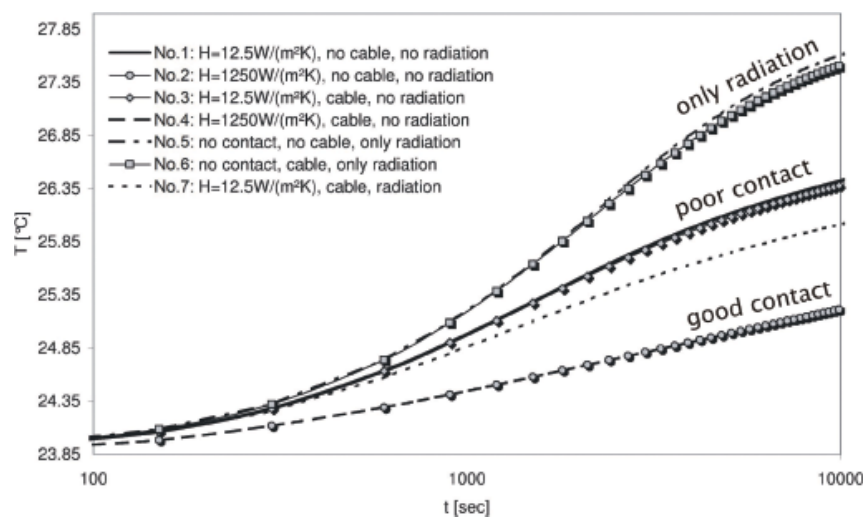
Fig. 15. Temperature response of the hollow cylindrical LNP01-sensor at the measurement point due to heating in a moderate conductivity sample with λ = 0 . 2Wm − 1 K − 1 .